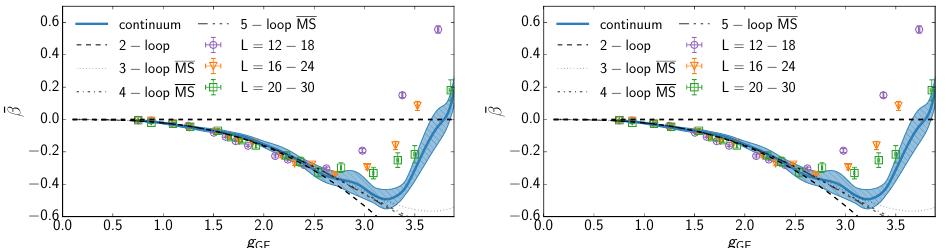
Figure 3. Left : The continuum extrapolated β -function of the six flavor theory. The gradient flow coupling has been measured with c t = 0.3. Right : The continuum extrapolated β -function of the eight flavor theory. The gradient flow coupling has been measured with c t = 0.4. In both panels, clover discretization and the τ 0 improvement has been used to reduce the